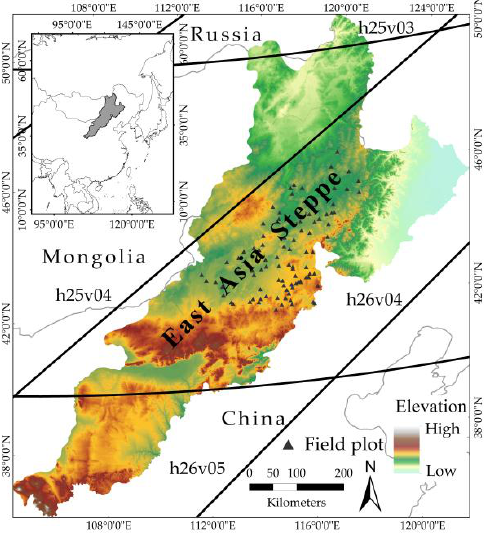
Figure 1. Location and topography of the East Asia steppe, with the grid of corresponding MODIS tiles and the site of the field survey (black triangle).